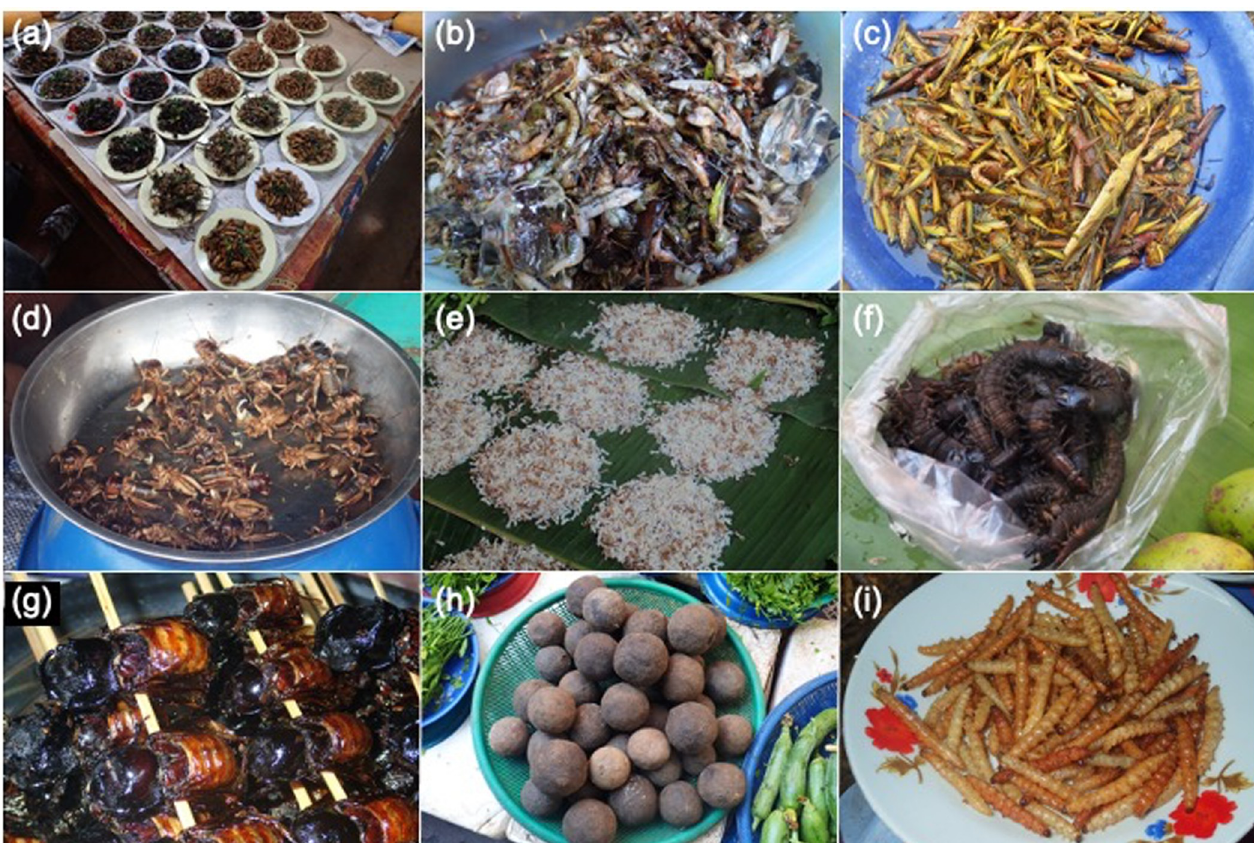
Fig 2. Edible insects observed at food markets in Laos. (a) Insects are usually classified roughly and sold on one dish. (b) Dragonfly nymphs are sold together with freshwater fish and shrimps. (c) Adults and nymphs of grasshoppers ( Atractomorpha sp., Acrida spp., Euconocephalus sp., etc.). (d) Adults of short-tailed crickets ( Brachytrupes portentosus ). (e) Larvae, pupae, and adults of weaver ants ( Oecophylla smaragdina ). (f) Larvae of dobsonflies (Family Corydalidae). (g) Fried rhinoceros beetles ( Trichogomphus martabani ), (h) Dung balls of elephant dung beetle ( Heliocopris bucephalus ). (i) Fried bamboo caterpillars ( Omphisa fuscidentalis